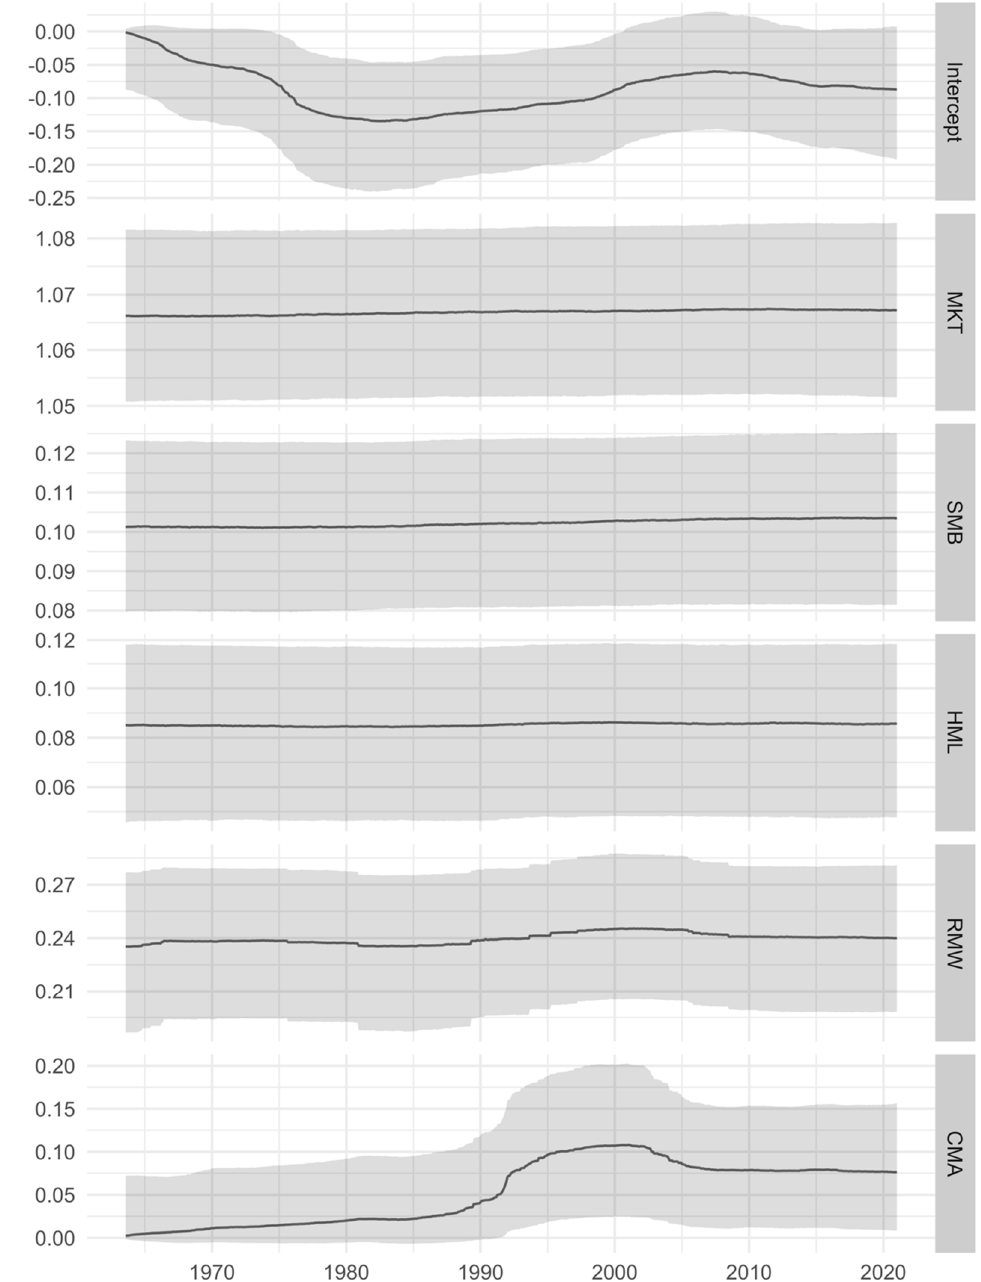
Figure 3. Threshold time-varying parameter beta estimates—Manufacturing. Note: The figure presents the plots for the posterior medians (solid line) with 68% confidence bands (gray shaded region) of the time varying beta estimates from the TTVP model with stochastic volatility. Gibbs sampling is used with 10,000 posterior and 10,000 burn-in draws. MKT, SMB, HML, RMW and CMA represent the Market, Size, Book-to-Market, Profitability and Investment factors based on the five-factor specification of Fama and French [57].